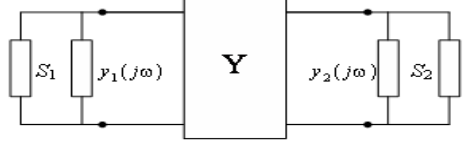
Fig. 1. System of two coupled